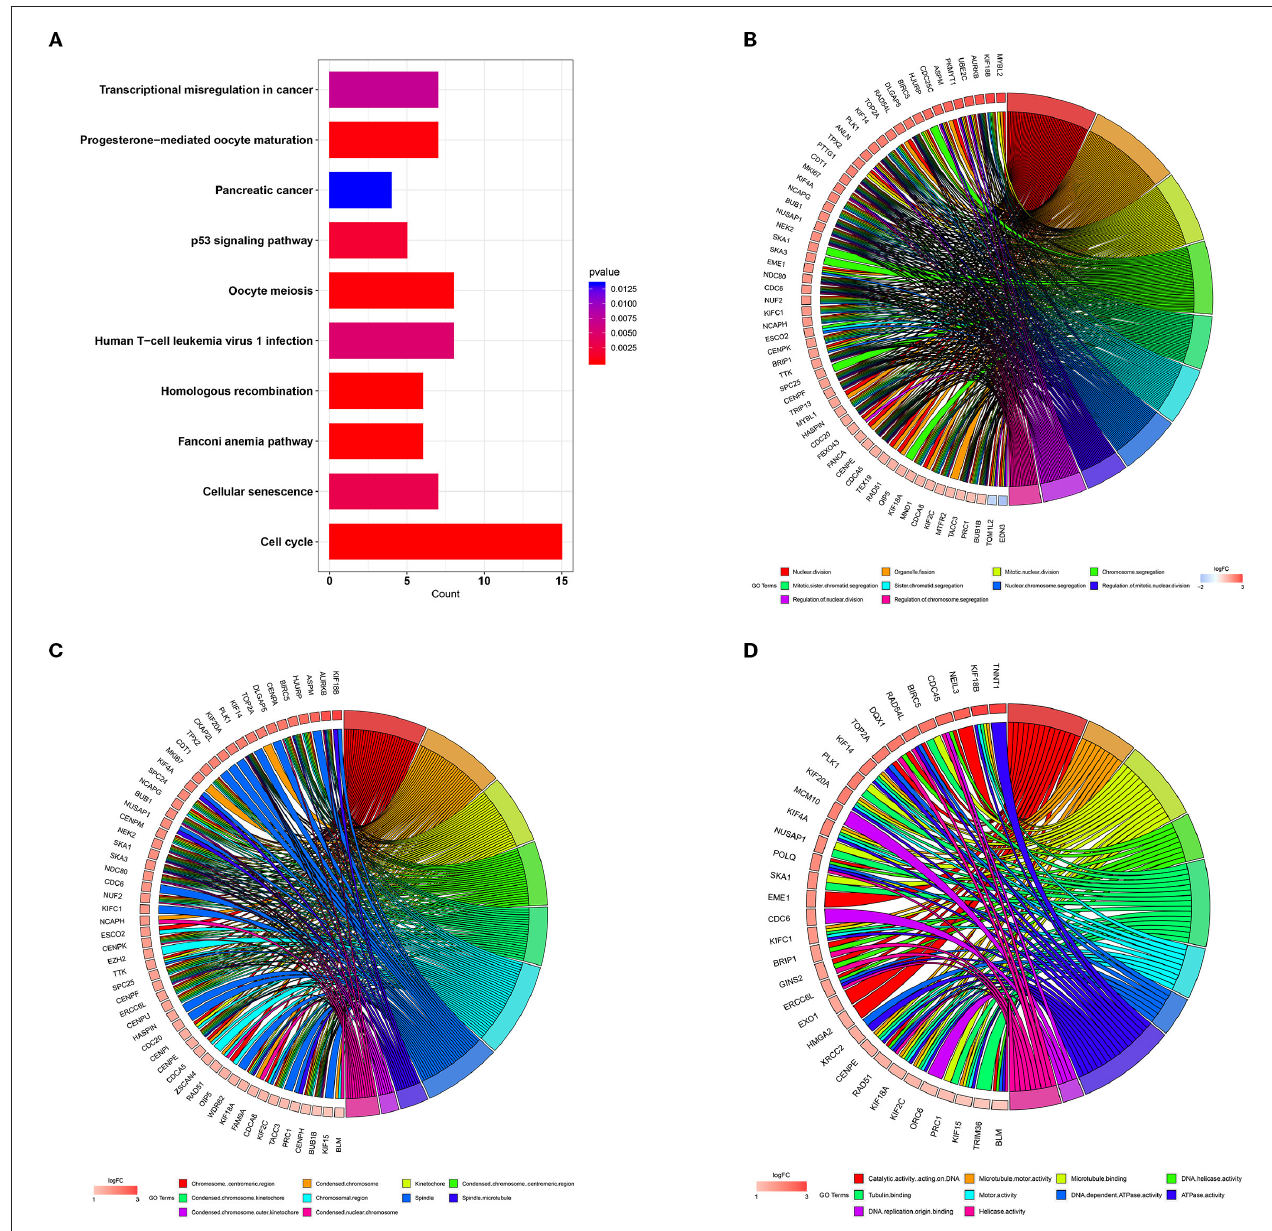
FIGURE 4 | Functional annotation for pink module. (A) The bar plot of top 10 most significant signaling pathways identified by KEGG pathway enrichment analysis. The chord diagram of top 10 most significant GO terms and related genes in biological process (B) cell component (C) and molecular function (D) . KEGG, Kyoto Encyclopedia of Genes and Genomes; GO, gene